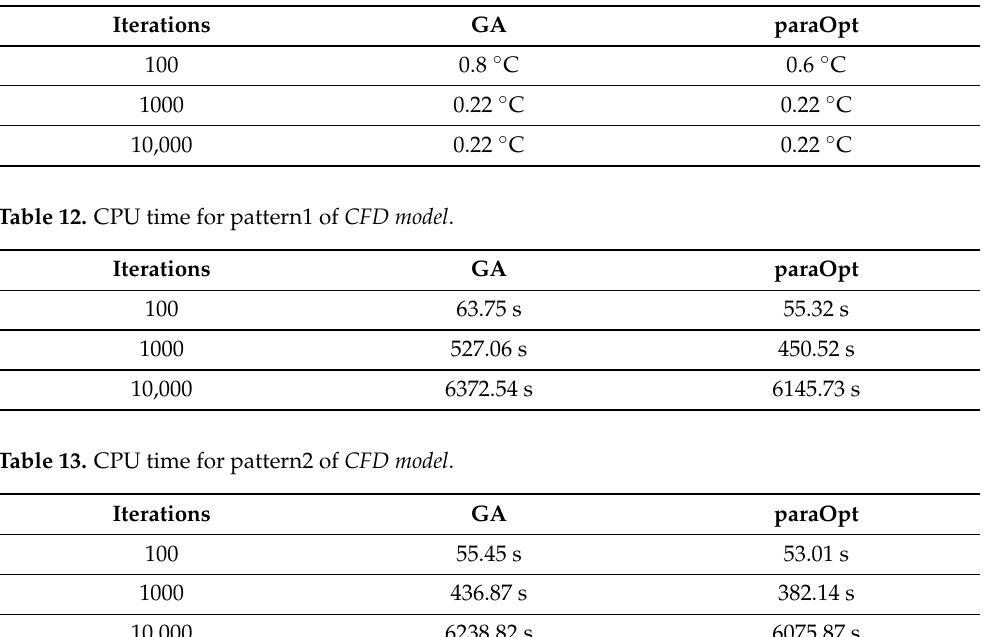
Table 11. Temperature for pattern2 of CFD model .